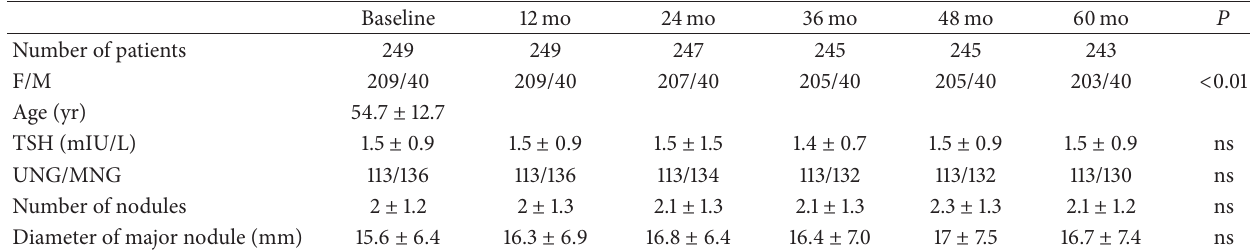
Table 1: Characteristics of study